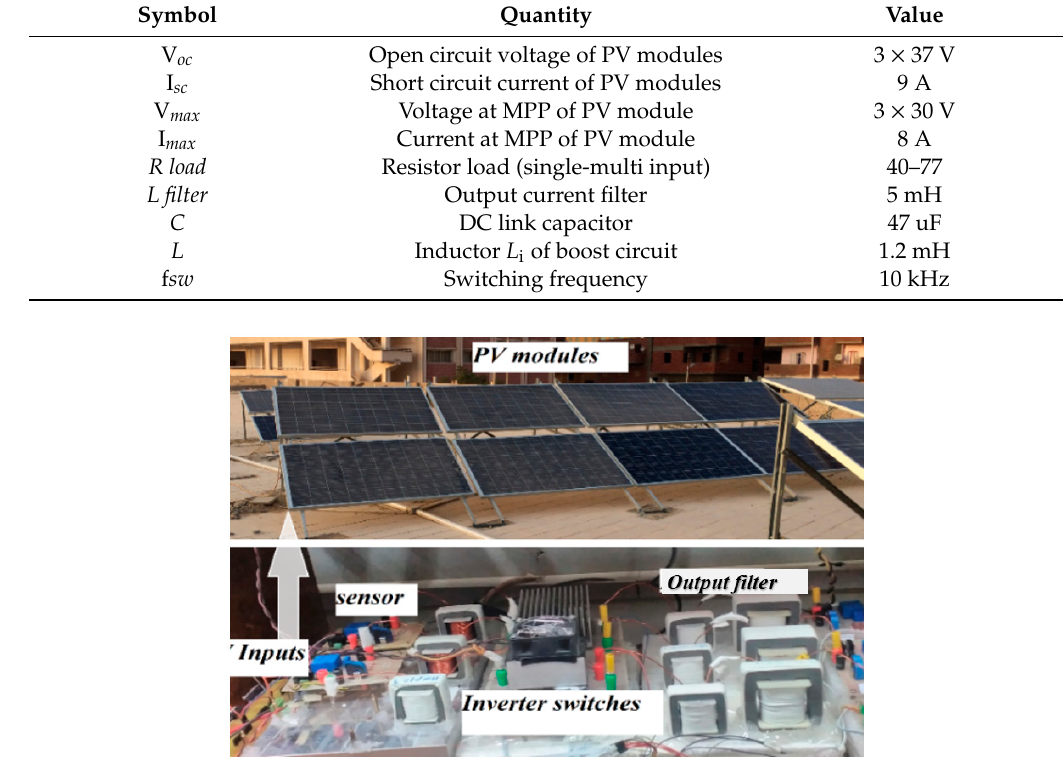
Figure 12. The experimental setup and PV modules.